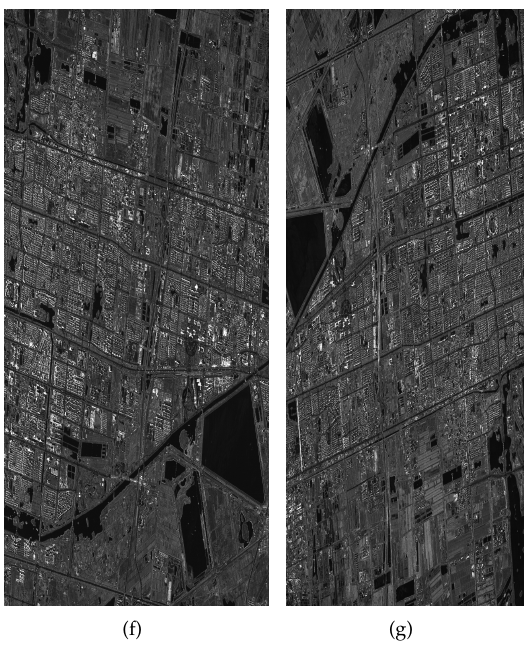
Figure 4. Experimental data for combined geopositioning: ( a ) GF2-1, ( b ) GF2-2, ( c ) GF2-3, ( d ) GF6-1,